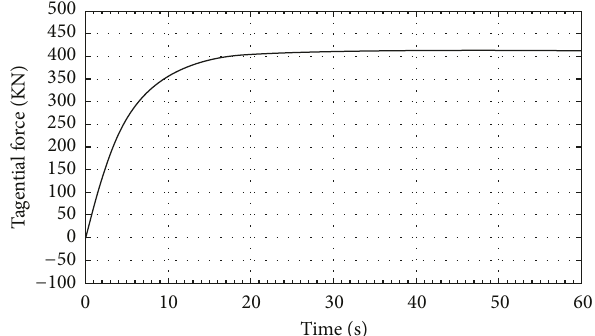
Figure 13: Tangential force due to nonholonomic constraints.